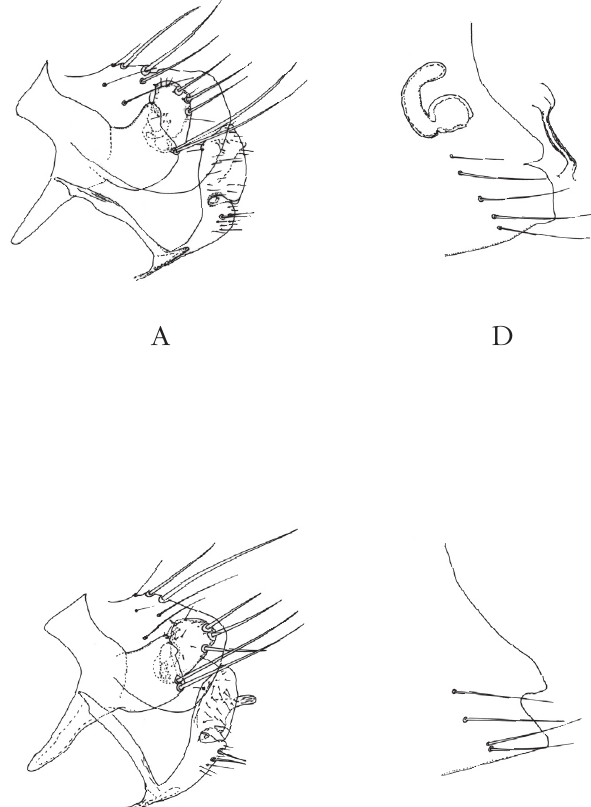
une  (Figure 5D) (A. Laudisoit rec. ) ( pro partei , in : Coll. J.-C. B. et A. L.).